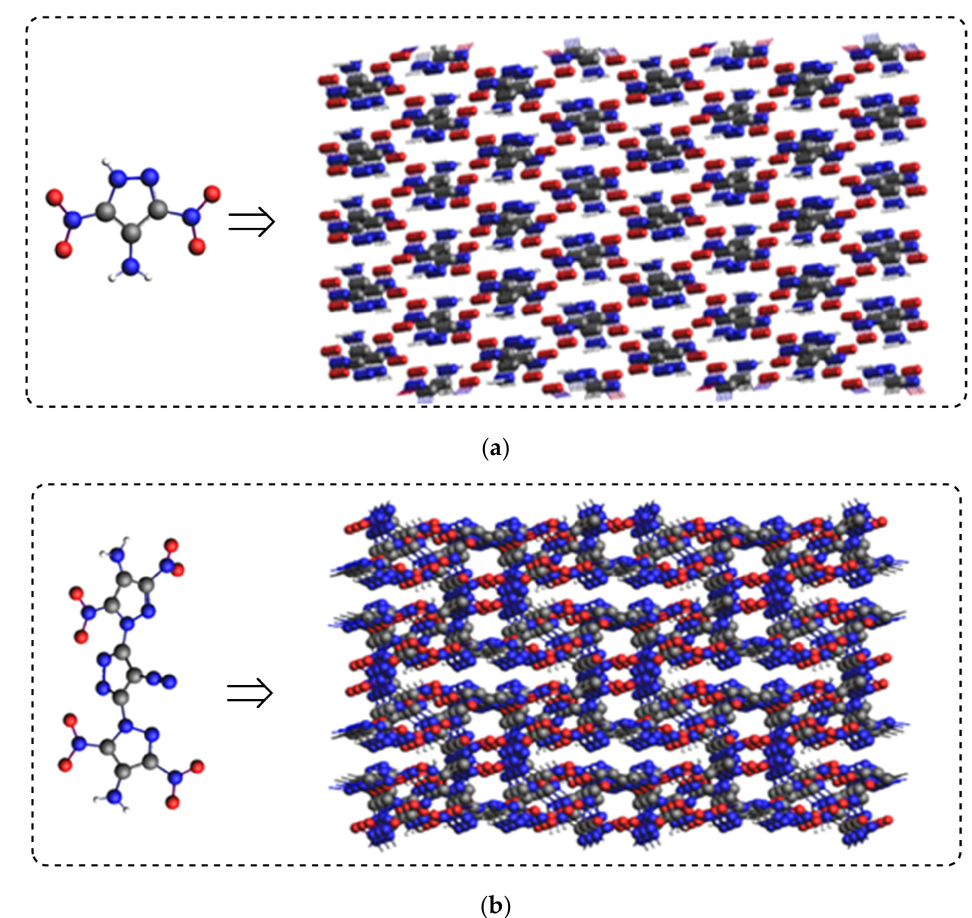
Figure 5. Molecular structures and super cells of LLM-116 ( a ) and LLM-226 ( b ).